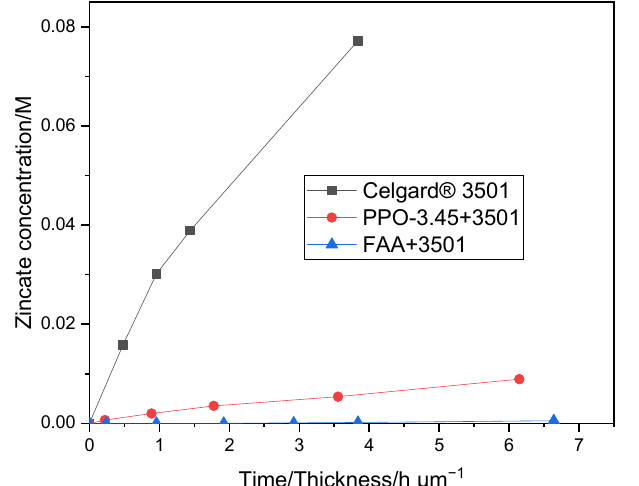
Figure 6. Zn(OH) 42 − crossover of Celgard ® 3501, and PPO-3.45 + 3501, FAA + 3501 as function of time/membrane thickness. Table 5. Zincate ions diffusion coefficient through the modified membranes.